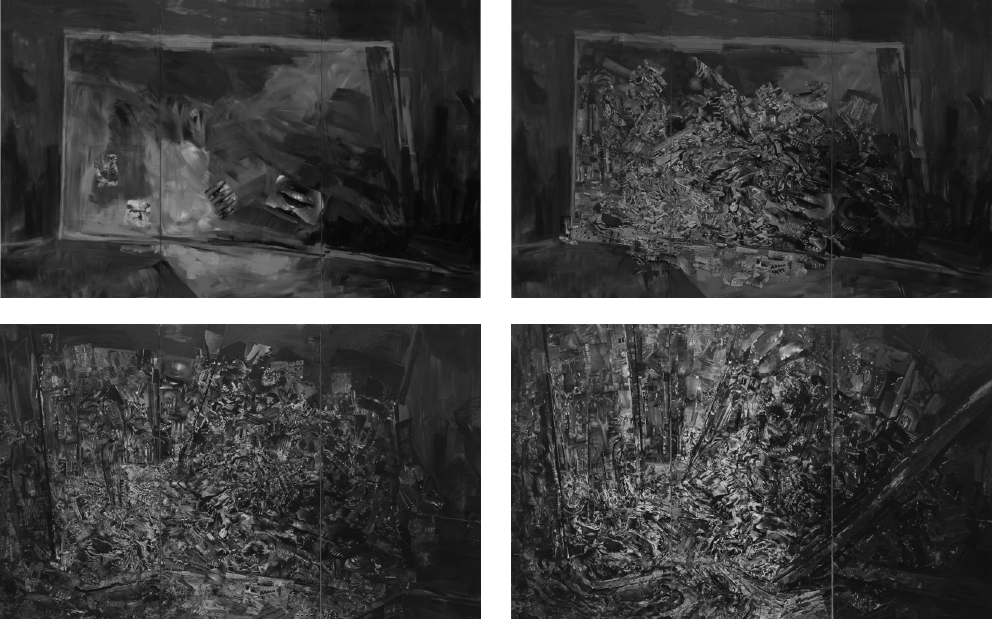
Fig. 3a - 3d Sabine Hertig, four stages of the development of Landscape 14 , February – September 2017, analogue collage on canvas, 300 x